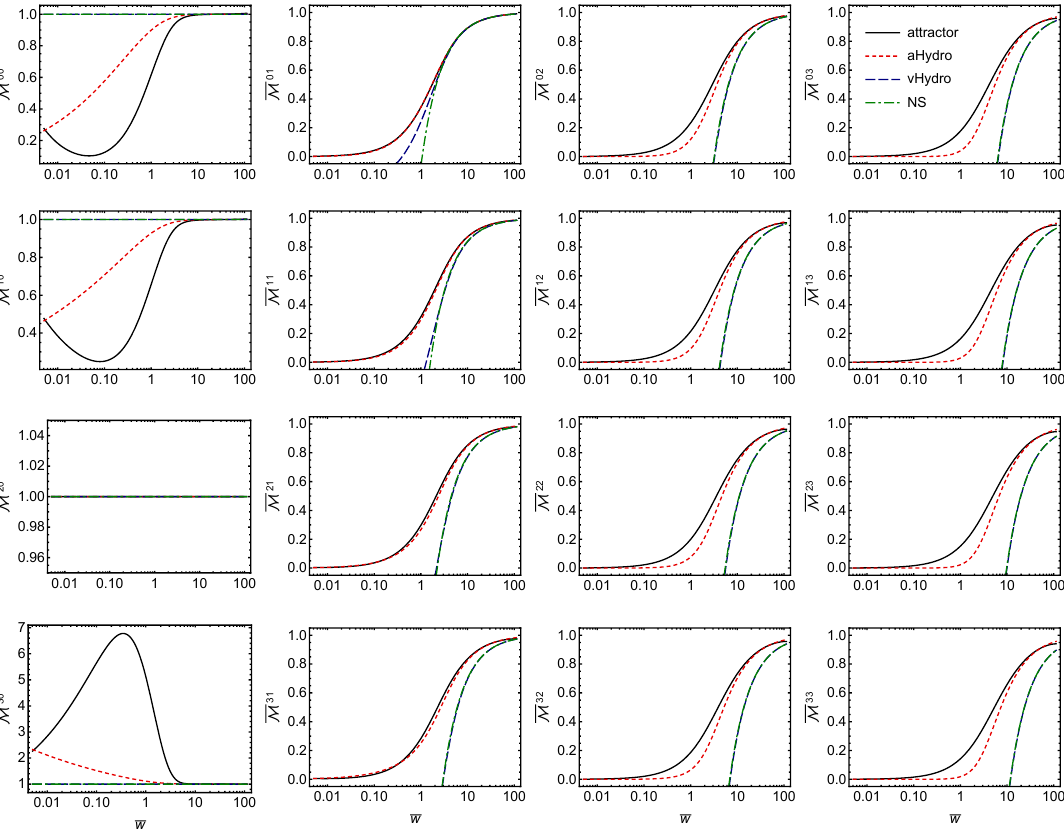
Figure 12 . Scaled moments M nm obtained from the exact attractor solution (solid black line) compared with the aHydro attractor (red dashed lines), DNMR attractor (blue long dashed lines), and the Navier-Stokes limit for each moment (green dot-dashed lines). Horizontal axis is (cid:22) w (cid:17) (cid:28)T= 5(cid:22) (cid:17) . Panels show a grid in n and m